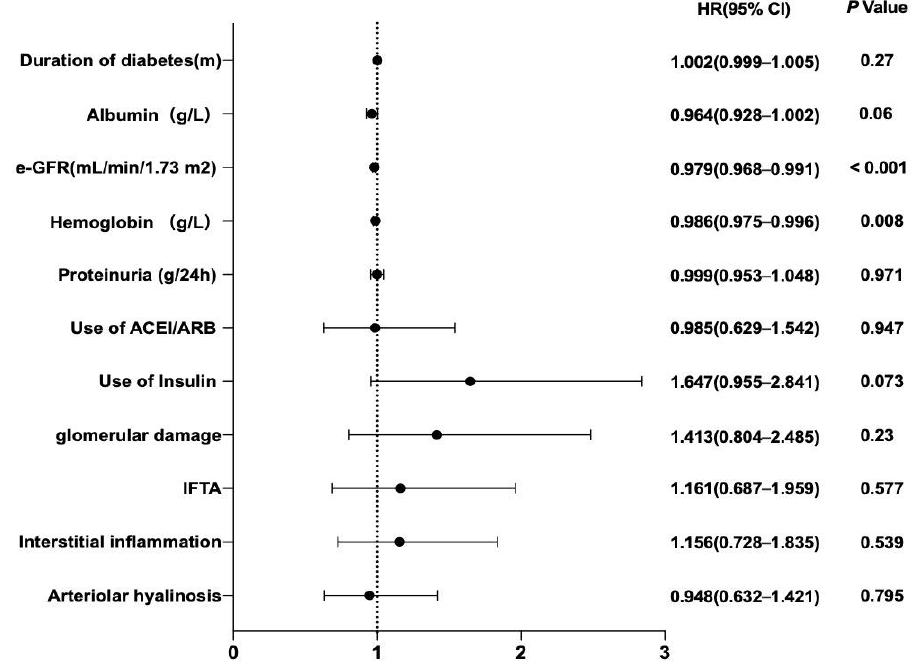
Figure 3. Risk factors for ESRD identified by multivariate Cox analysis in DKD patients with nephrotic range proteinuria. e-GFR, estimated glomerular filtration rate. IFTA, interstitial fibrosis and tubular atrophy. A two-tailed p < 0.05 was considered statistically significant.